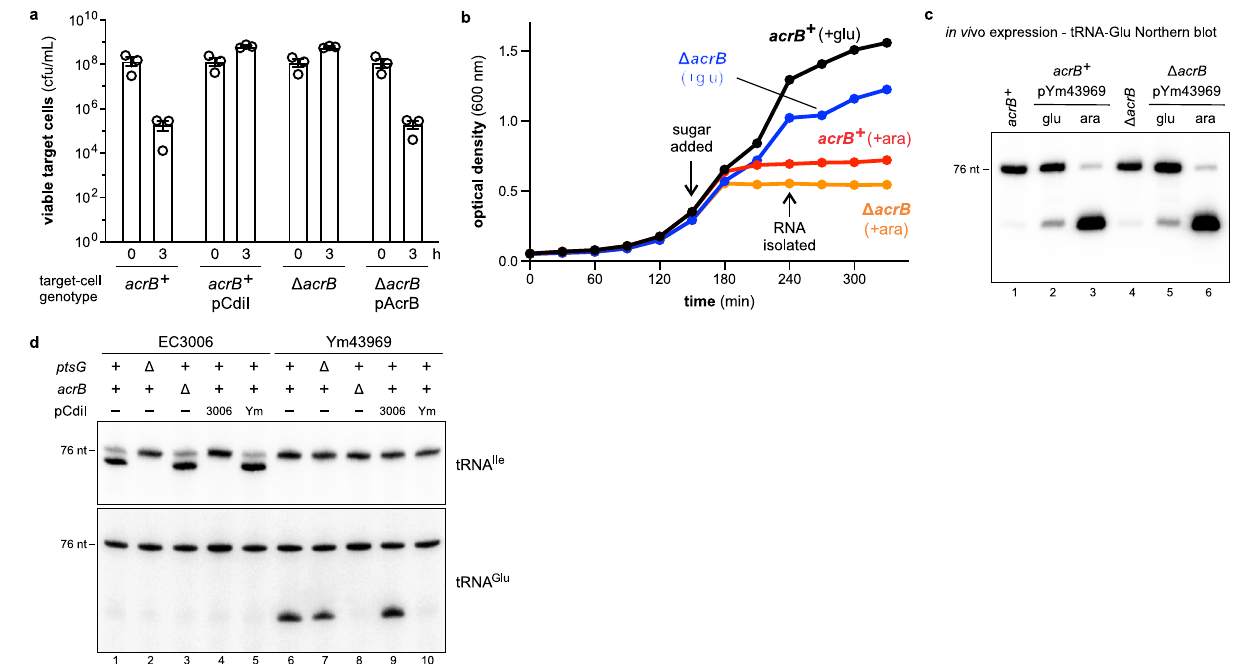
Fig.3|CdiA-CTsfollowindependent,parallelentrypathways.a Competitionco- cultures. Target bacteria were mixed at a 1:1 ratio with inhibitor cells that deploy CdiA-CT Ym43969 and viable target cells were enumerated as colony-forming units (cfu) per mL at 0 and 3h. Presented data were the average±SEM for three inde- pendent experiments. b Internal toxin production. cdiA-CT Ym43969 expression was induced with arabinose (+ara) or repressed with glucose (+glu) in E. coli acrB + and Δ acrB cells. Cell growth was monitored by optical density. Presented data are the average for two independent experiments. c RNAs isolated from cells in panel